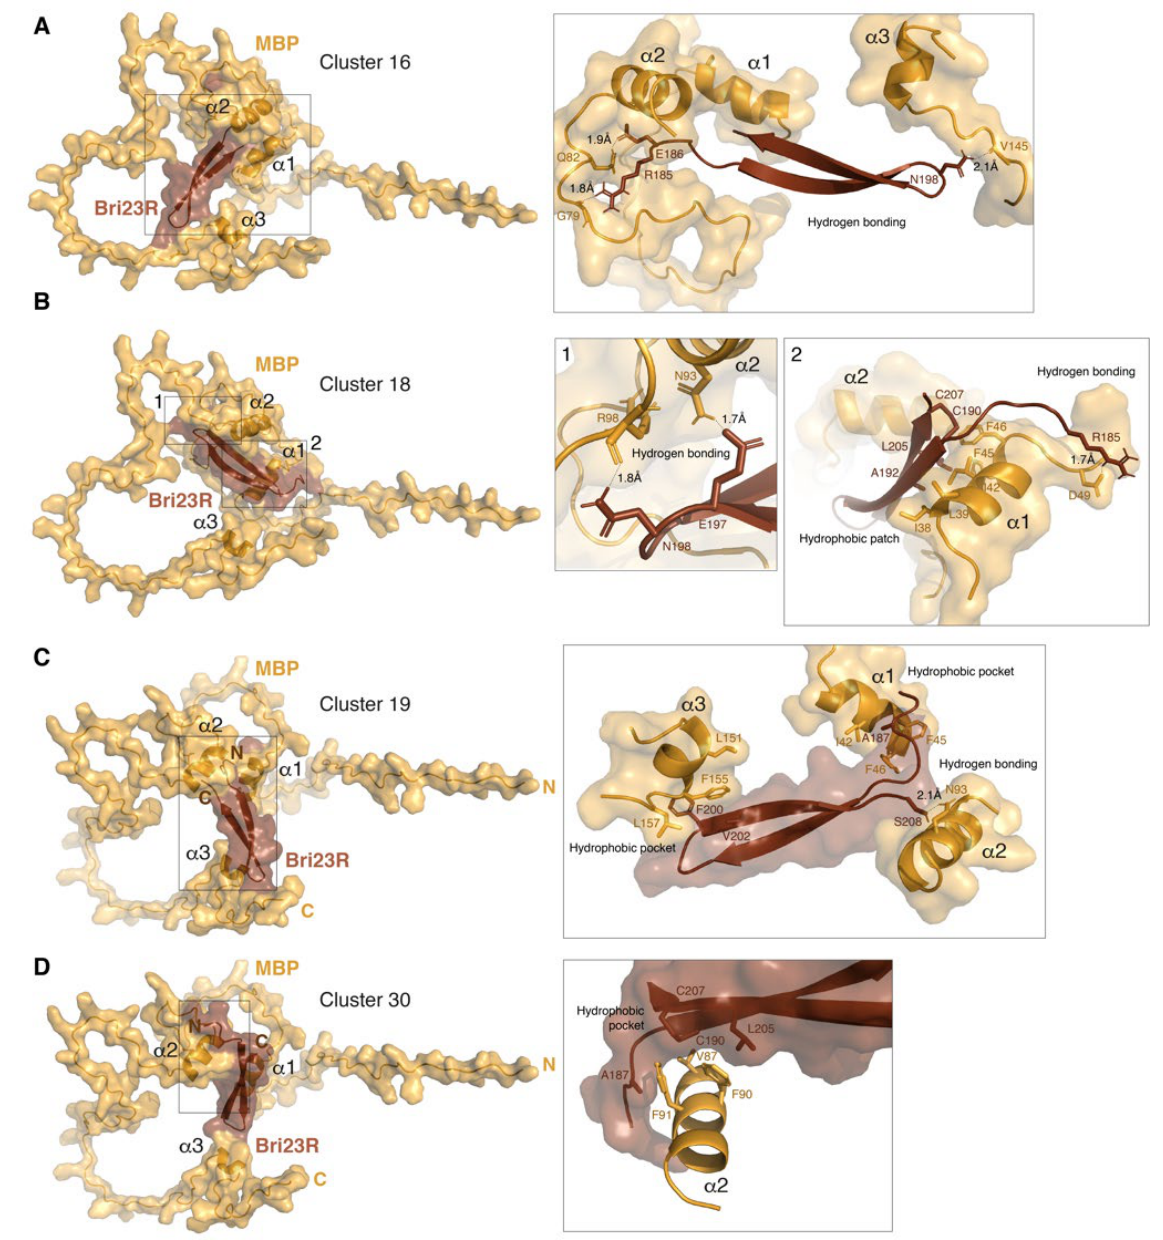
Figure 4. HADDOCK-predicted complexes MBP/Bri23R. The representative structures of lowest en- ergy clusters obtained for the best 30 HADDOCK-generated complexes are shown as surface/ribbon pictograms generated by PyMol and numbered 16 ( A ), 18 ( B ), 19 ( C ) and 30 ( D ) according to their automatic enumeration generated by HADDOCK. MBP is colored bright orange and Bri23R is colored chocolate. Details of polar and hydrophobic intermolecular interactions are shown in the inserts on the right side. Interacting residues are shown by sticks.